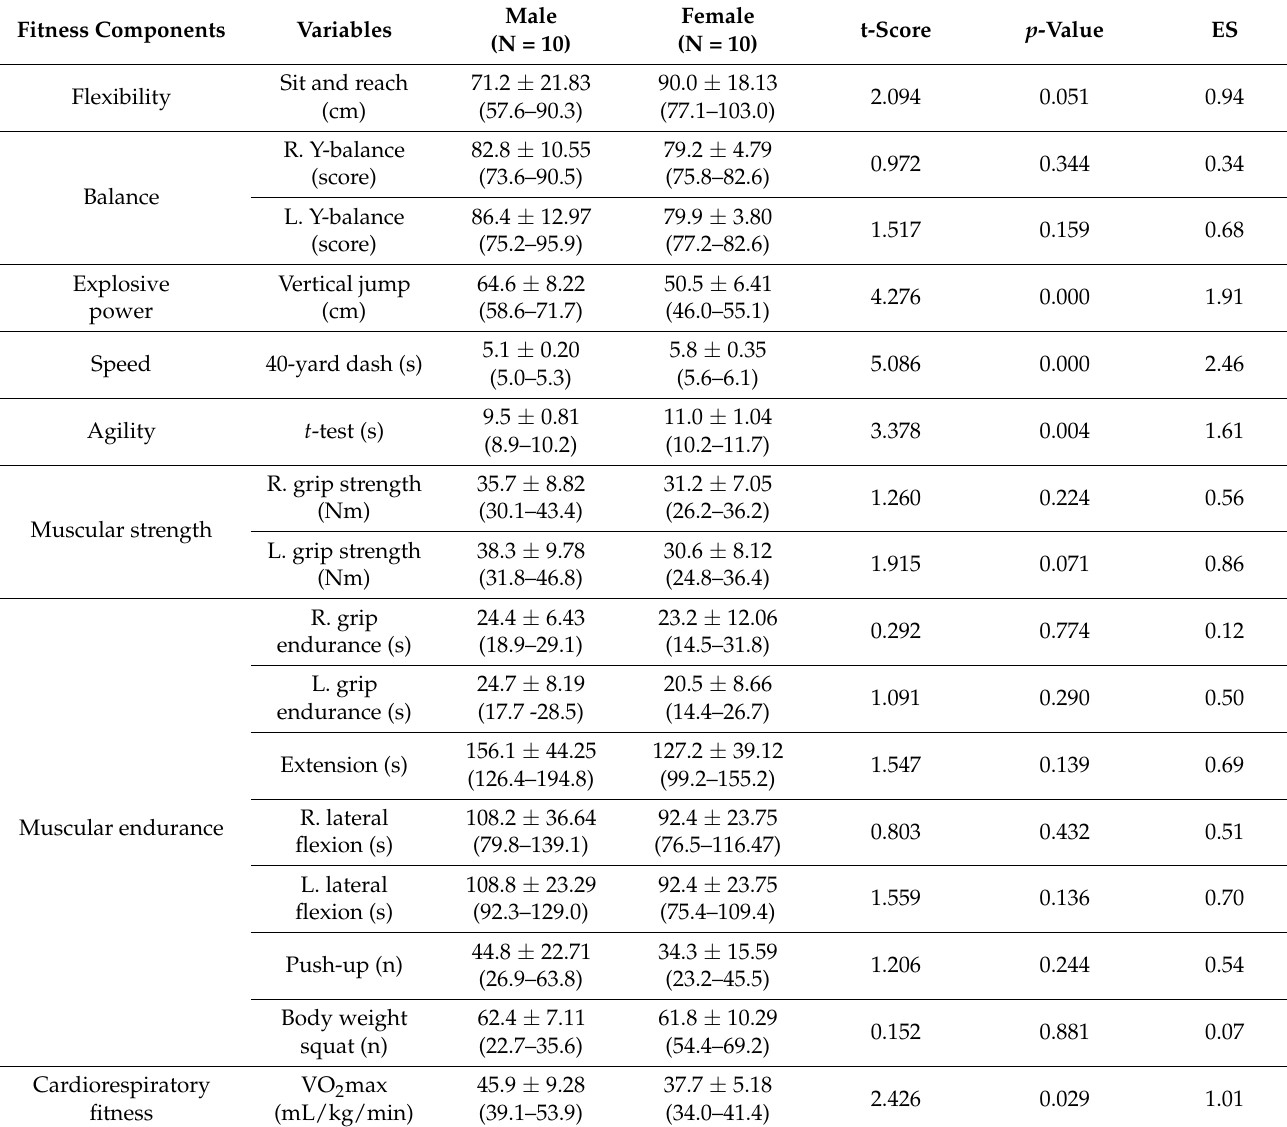
Table 2. Physical fitness in collegiate water skiers (M ±